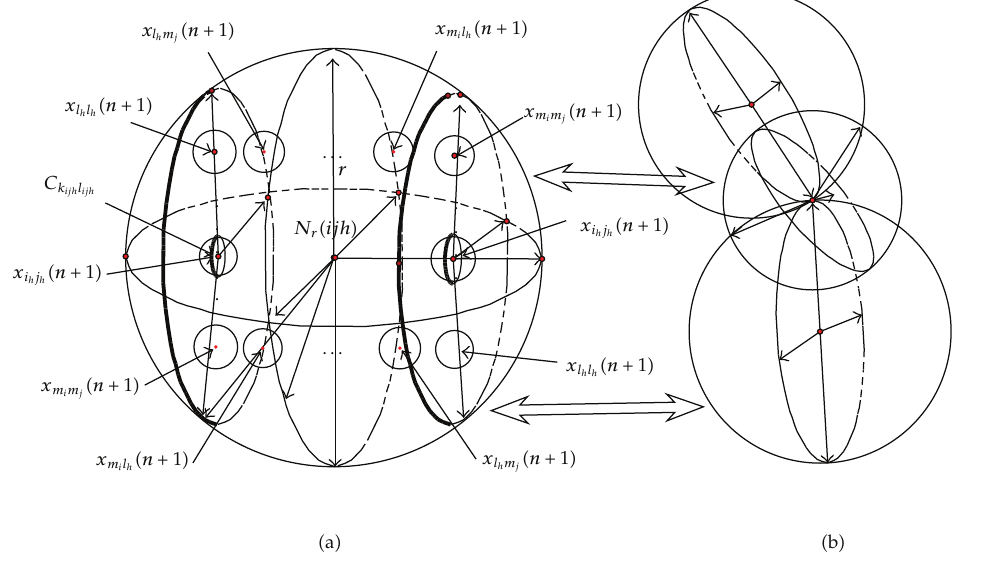
Figure 1: Spatial structure with respect to (cid:3) 1.3 (cid:4)